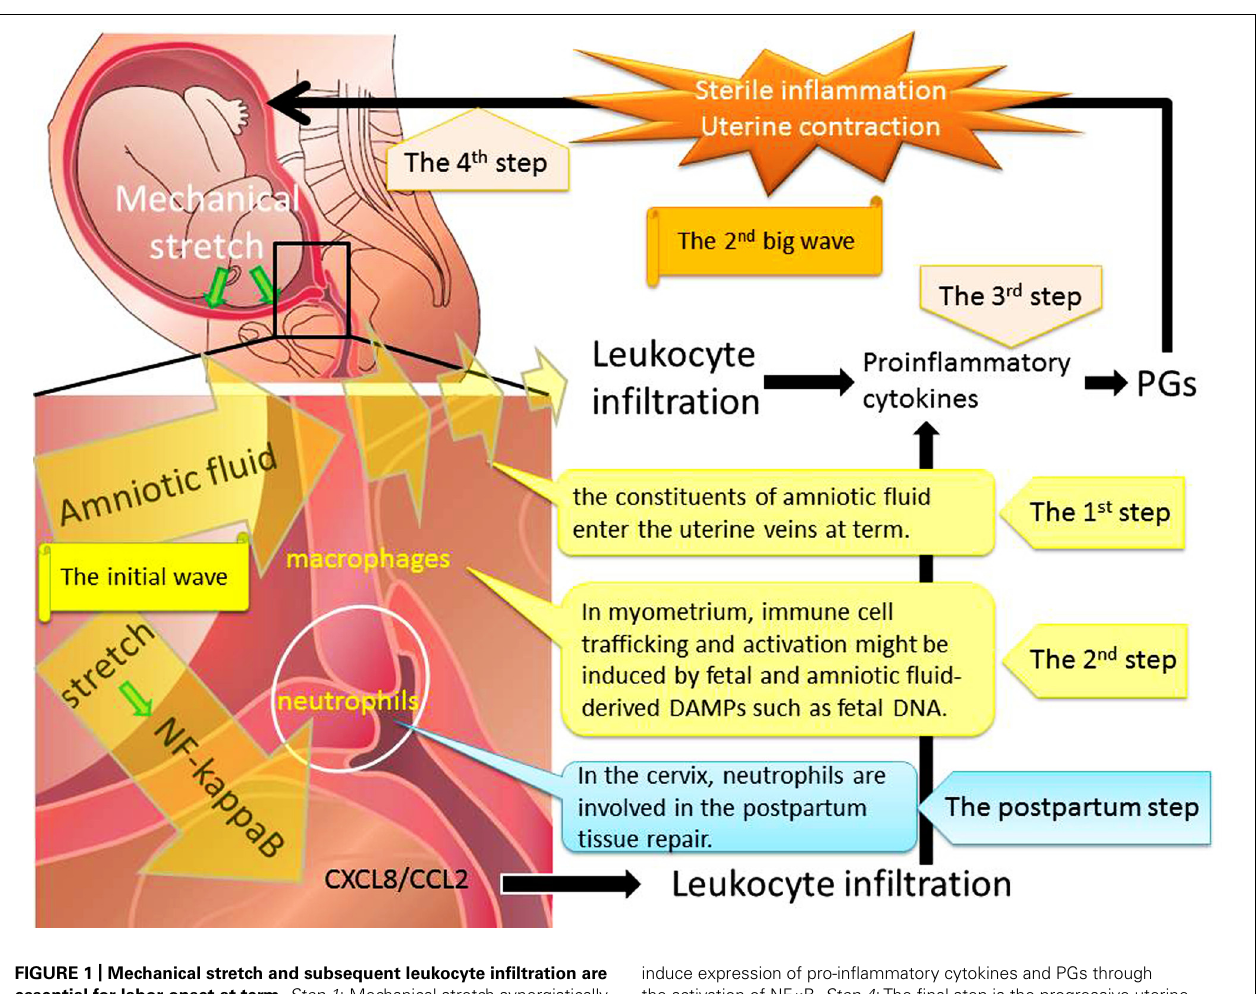
FIGURE 1 | Mechanical stretch and subsequent leukocyte infiltration are essential for labor onset at term. Step 1 : Mechanical stretch synergistically augmented leukocyte infiltration and production of pro-inflammatory chemokines via the NF- κ B pathway. Step 2 :The entry of amniotic fluid components into uterine vasculatures promoted myometrial infiltration with macrophages and neutrophils. Step 3 : Infiltrating leukocytes could